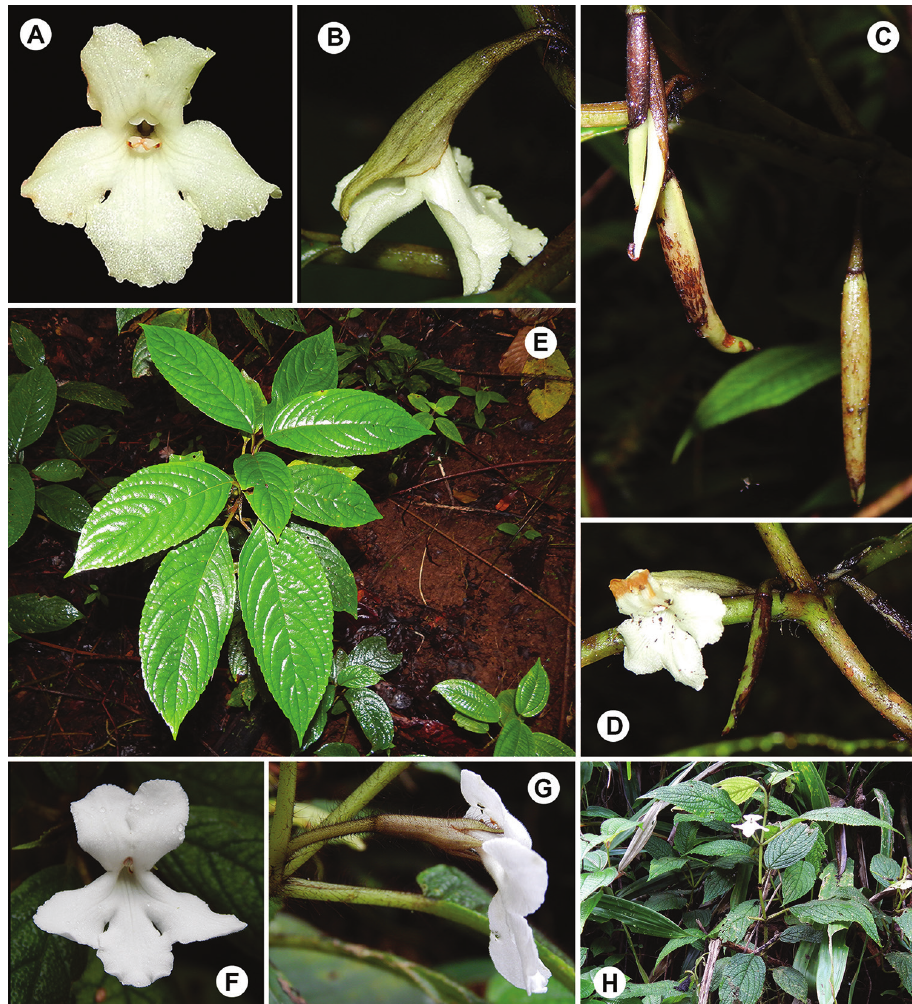
Figure 8. Cyrtandra longifructosa M.A.Johnson and closest relative ( C. dolichocarpa ) based on molecular phylogeny by Johnson et al. (2017). A C. longifructosa corolla, anterior view B C. longifructosa flower, lat- eral view C C. longifructosa elongate cylindrical fruits D C. longifructosa axillary inflorescence and young fruits E C. longifructosa shrub habit F C. dolichocarpa corolla, anterior view G C. dolichocarpa flower, lateral view H C. dolichocarpa shrub habit. All photos taken in the field by M. Johnson, with photos of C. longifructosa taken from the type